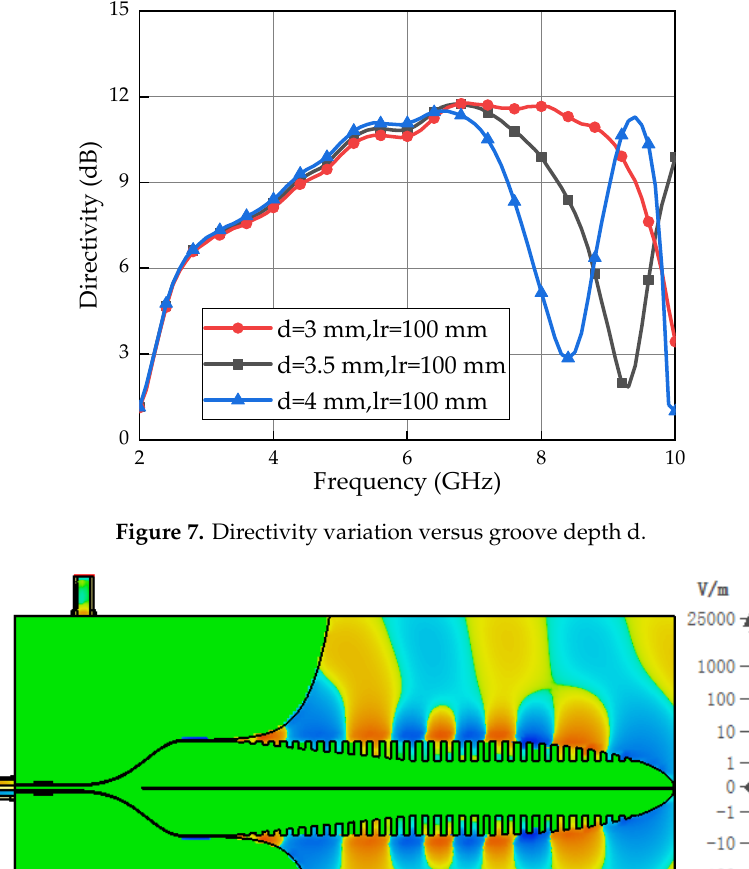
Table 1. Dimensions of the proposed antenna